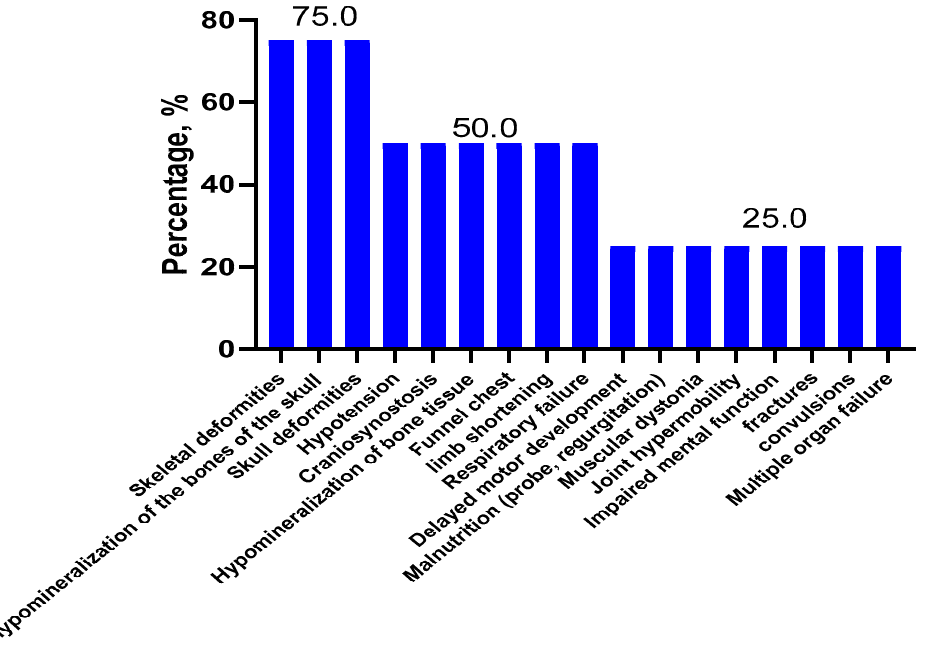
Figure 2. Clinical symptoms of HPP in children with perinatal HPP ( n = 4).